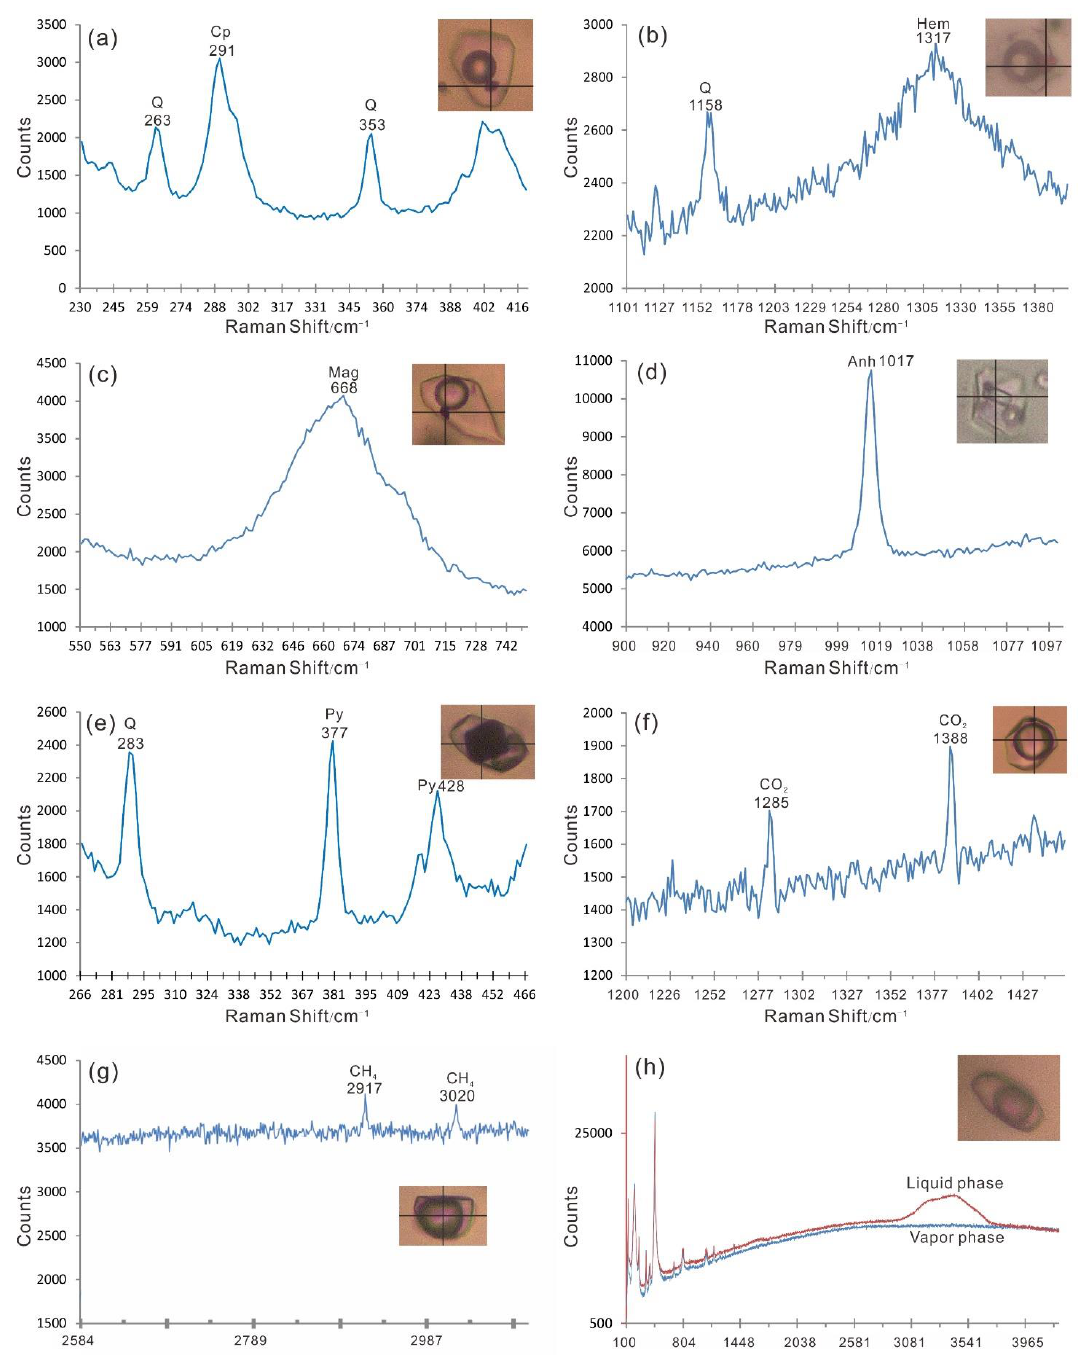
Figure 7. Laser Raman spectra of typical fluid inclusions (FI) in Cu- and Mo-bearing veins. ( a ) Curves and peaks of the Raman shift around chalcopyrite (Cp) (S 1 -type FI in a Cu-bearing vein; ZK1614-118.8 m); ( b ) curves and peaks of the Raman shift around hematite (Hem) (S 1 -type FI in a Cu-bearing vein; ZK1615-67.5 m); ( c ) curves and peaks of the Raman shift around magnetite (Mag) (S 1 -type FI in a Cu-bearing vein; ZK1617-53.7 m); ( d ) curves and peaks of the Raman shift around anhydrite (Anh) (S 2 -type FI in a Cu-bearing vein; ZK1615-311 m); ( e ) curves and peaks of the Raman shift around pyrite (Py) (S 1 -type FI in a Mo-bearing vein; ZK1616-194 m); ( f ) curves and peaks of the Raman shift around CO 2 (S 1 -type FI in a Cu-bearing vein; ZK1616-167 m); ( g ) curves and peaks of the Raman shift around CH 4 (V-type FI in a Mo-bearing vein; ZK1614-795.3 m); ( h ) wide H 2 O peaks detected in the liquid and vapor phases (L-type FI in a Mo-bearing vein; ZK1614-795.3